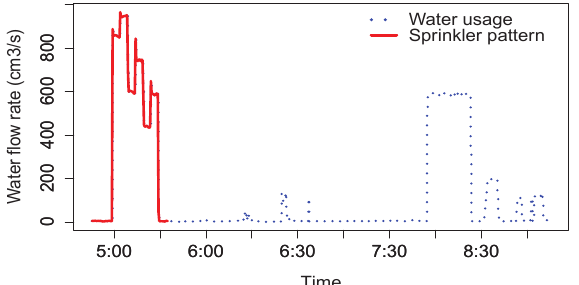
Figure 5: Water usage pattern for six sprinkler stations